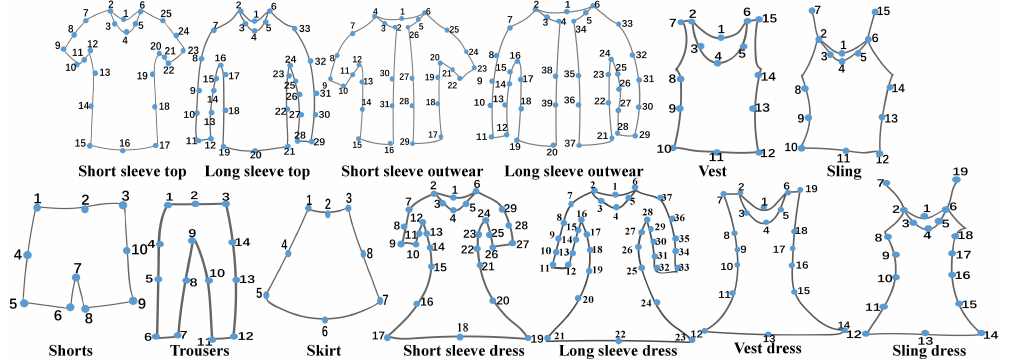
Figure A1. Definitions of landmarks in DeepFashion2